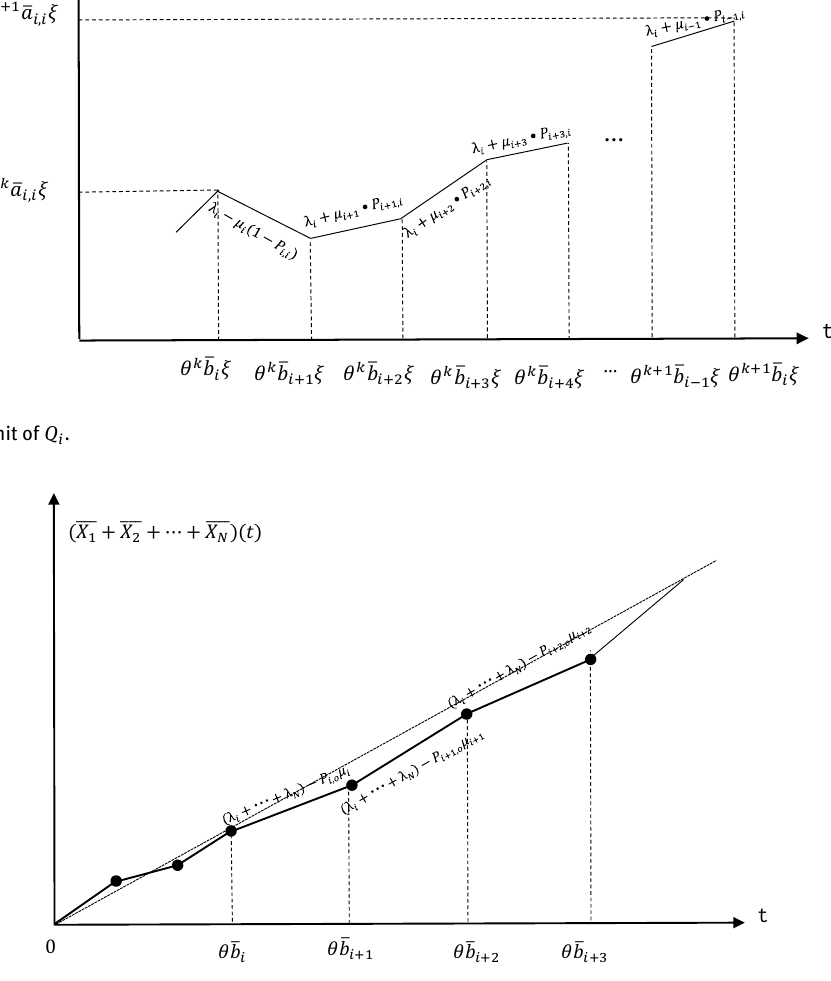
Figure 2: Fluid limit of total population ¯ X 1 + ··· + ¯ X N